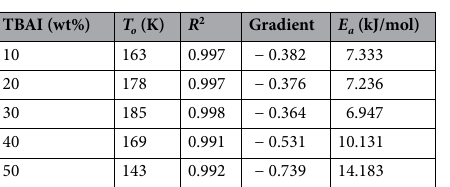
Figure 3. Number density ( n ), mobility ( µ ) and diffusion coefficient ( D ) of charge carriers at various temperatures.